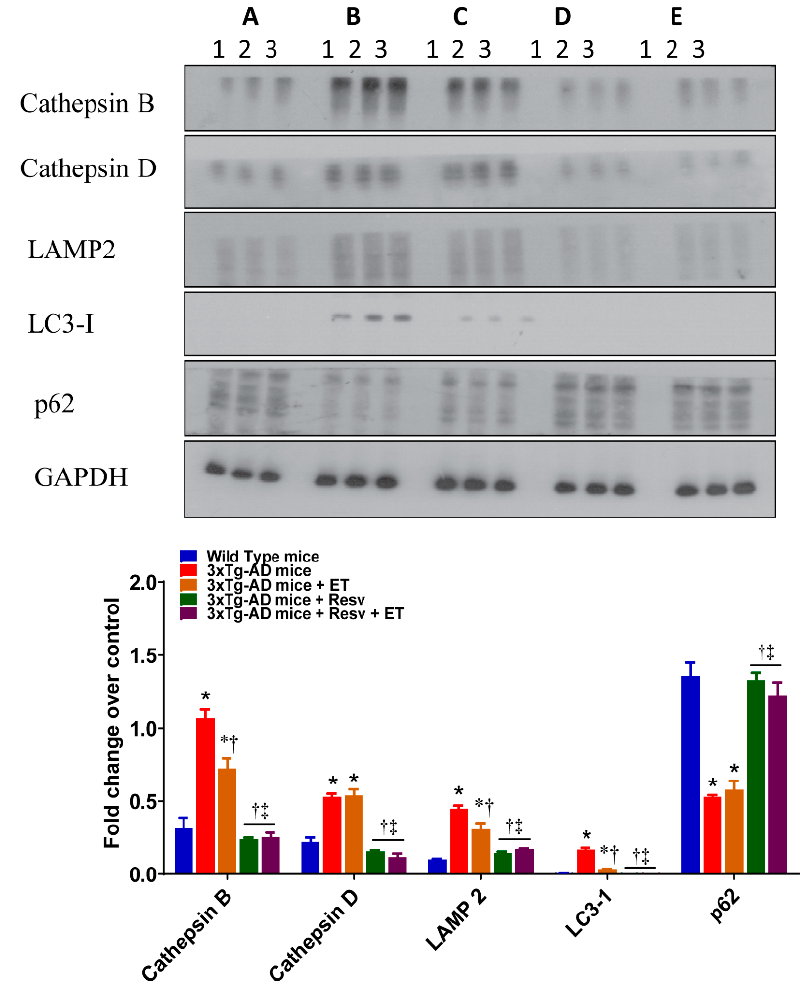
Figure 6 . The effects of Resv and ET on the expression of markers of autophagy. Treatment with Resv or Resv with ET decreased protein expression of key autophagy markers. Autophagy was expressed using LC3-1 and Cathepsin B, Cathepsin D, and LAMP2 were measured as endolysosomal markers. Representative immunoblots show significant reductions in the expression of all markers with ET, Resv, and Resv with ET. The significant decrease in the expression p62 in brains of 3xTg-AD mice was prevented with Resv or Resv with ET. Corresponding densitometry measurements: A, WT mice; B, 3xTg-AD mice; C, 3xTg-AD mice+ET; D, 3xTg-AD mice + Resv; E, 3xTg-AD mice + Resv + ET. LAMP2, lysosomal-associated membrane protein; LC3-1, microtubule-associated protein 1 light chain 3 beta; p62, sequestosome 1/ubiquitin-binding protein. AD, Alzheimer’s disease; ET, exercise training; Resv, resveratrol. Data are presented as mean ± SEM for 3 mice per group. *, compared to WT mice, p < 0.05; † , compared to 3xTg-AD mice, p < 0.05; ‡ , compared to 3xTg-AD mice + ET, p < 0.05.